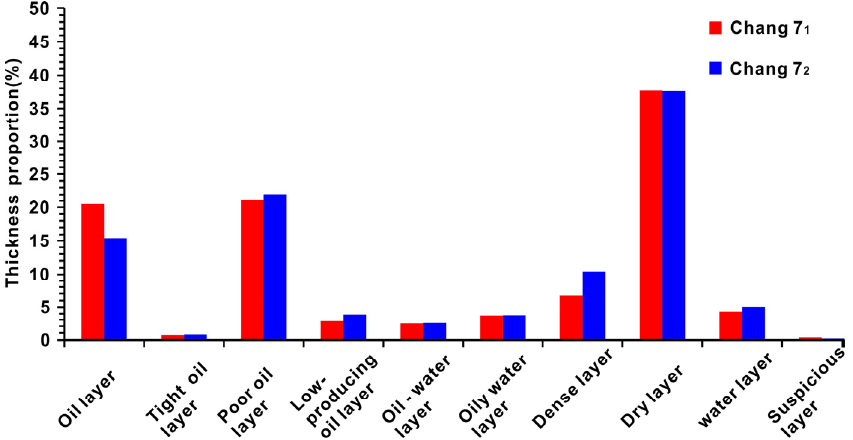
Figure 14. Developmental characteristics of the oil layer in the Chang 7 1-2 sub-member.